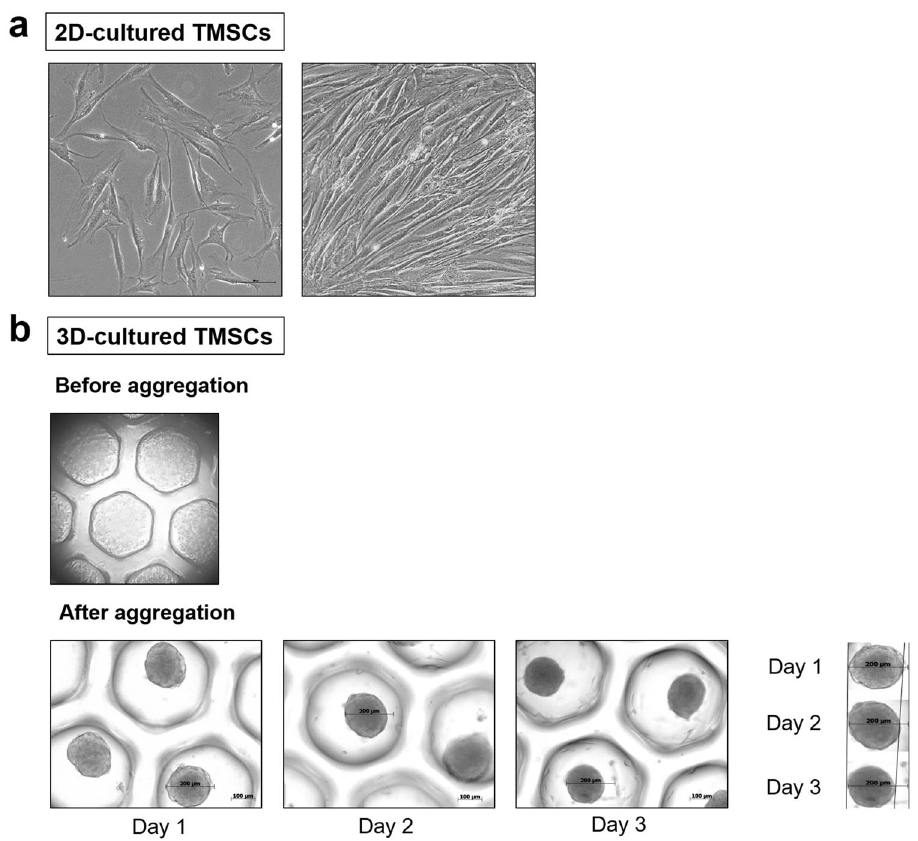
Figure 1. Macroscopic morphology of 2D-cultured and 3D-cultured TMSCs. ( a ) Macroscopic morphology of 2D-cultured TMSCs. ( b ) Macroscopic morphology of 3D-cultured TMSCs. 3D-cultured MSC spheroids had an average size of 182.4 µm on day 1, 169.4 µm on day 2, and 154.1 µm on day 3, and the size of spheroids gradually decreased after 2 days of culture. 2D, two-dimensional; TMSCs, tonsil-derived mesenchymal stem